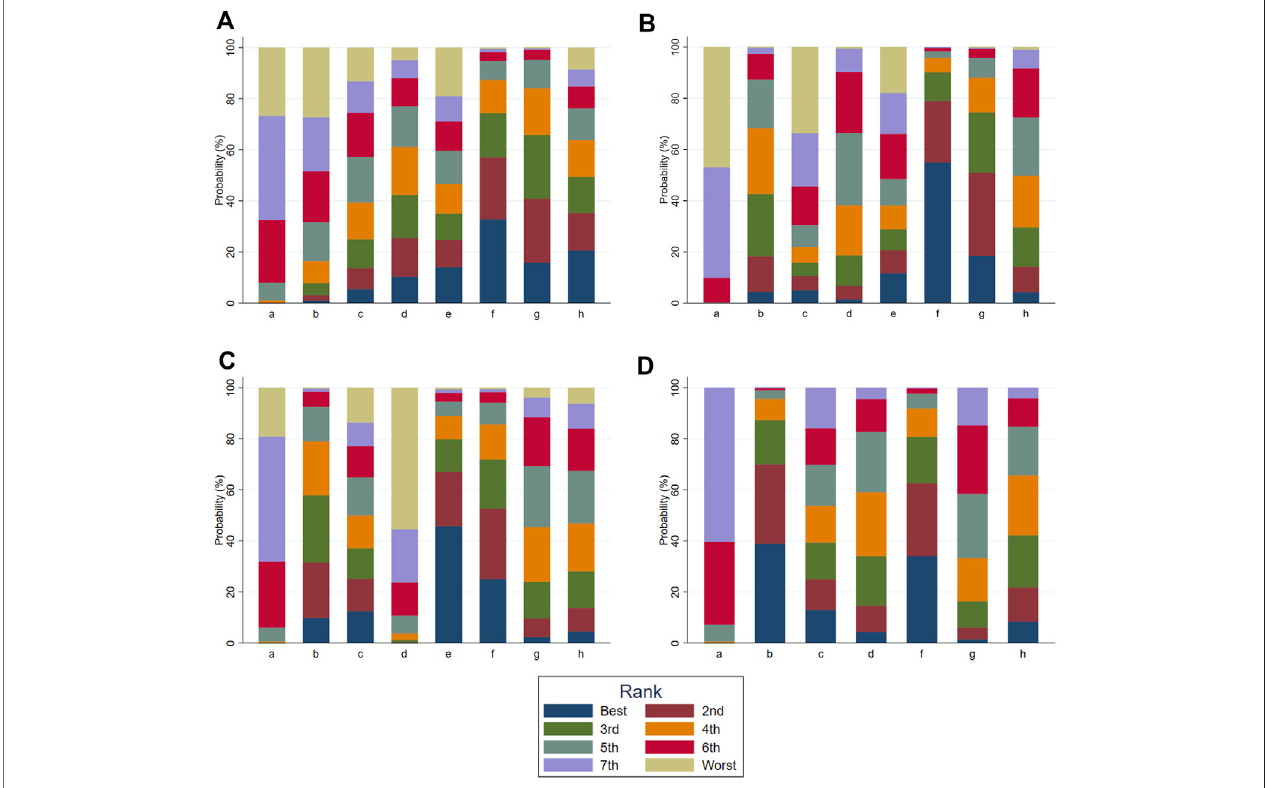
FIGURE 4 | Ranking probabilities of all intervention plan at different possible rankings. Notes: a: UDCA, b: Yinzhihuang oral liquid + UDCA, c: salvia injection + UDCA,d:Yinchenhaodecoction+UDCA,e:thesimilarprescriptionofYinchenhaodecoction1+UDCA,f:thesimilarprescriptionofYinchenhaodecoction2+UDCA,g: the similar prescriptionofYinchenhaodecoction 3+UDCA, and h: other traditional Chinesemedicine prescriptions +UDCA. (A) Pruritusscore. (B) Totalbileacid (TBA). (C) Alanine aminotransferase (ALT). (D) Aspartate transaminase (AST).